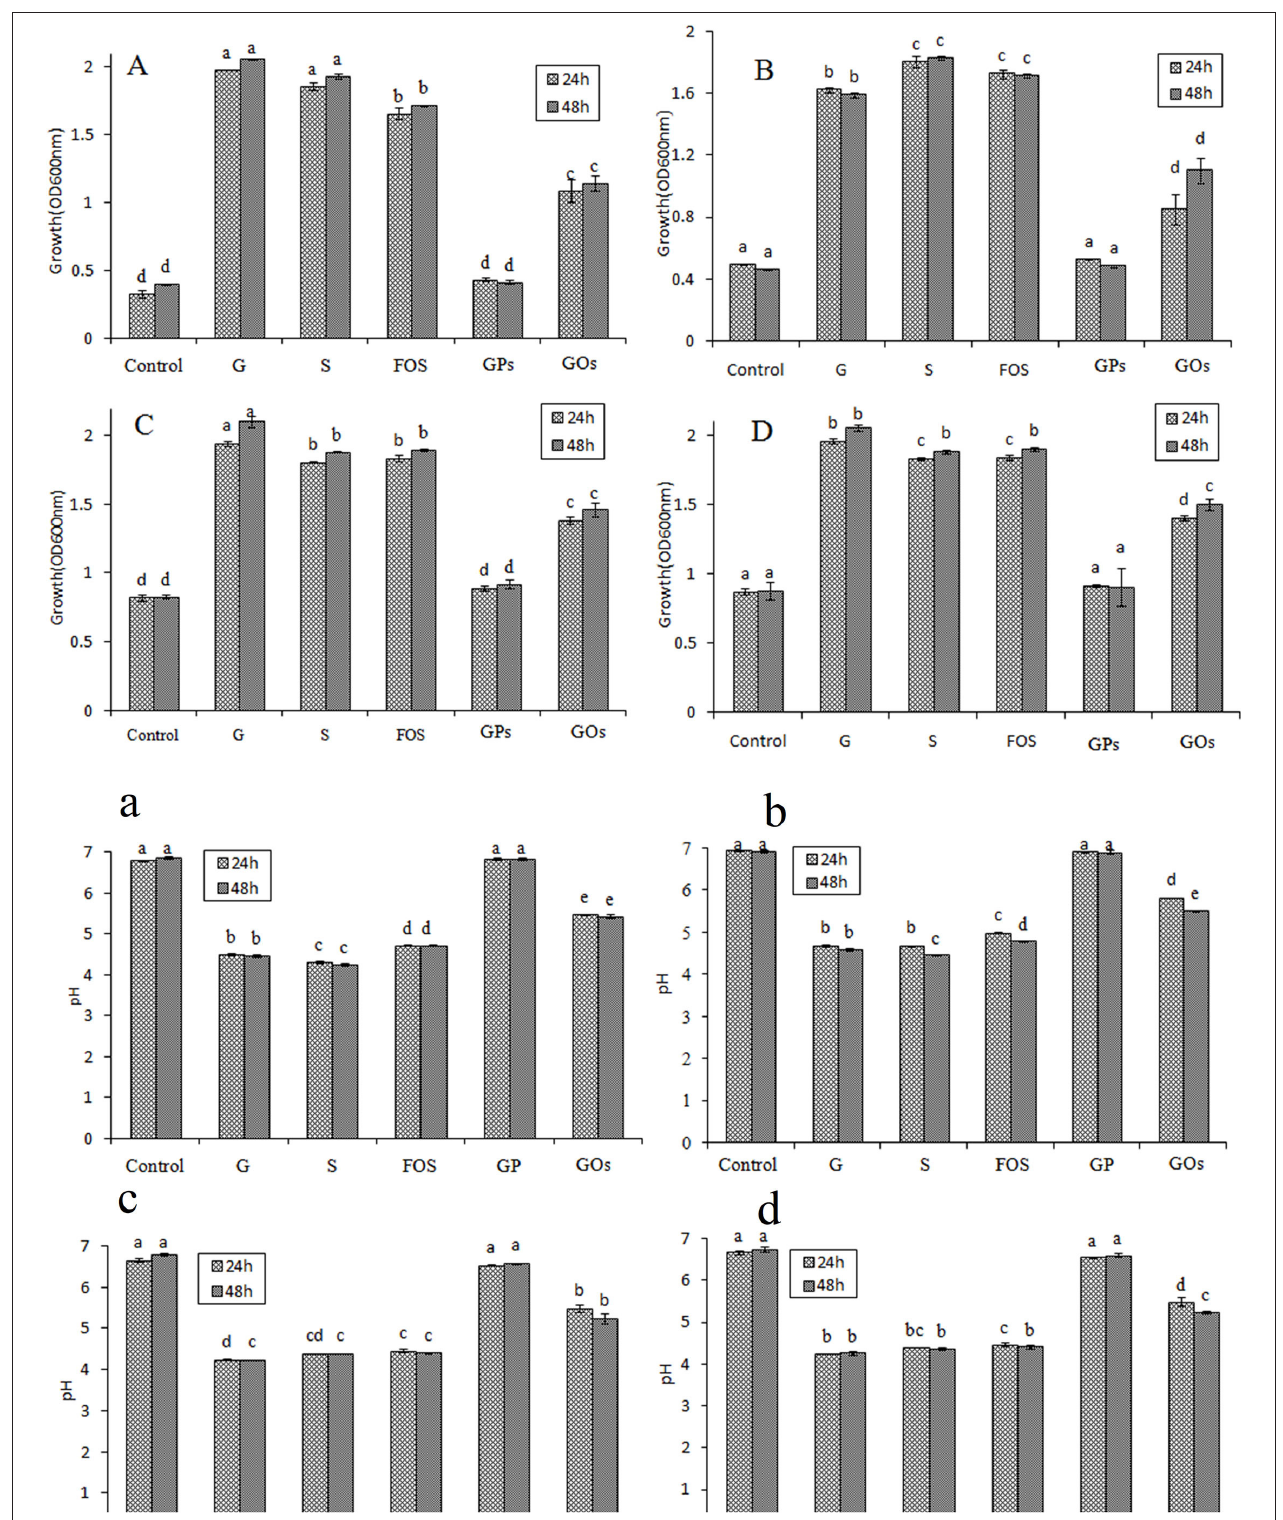
FIGURE 4 | Effects on the growth of Lactobacillus and pH of the medium at 24 and 48h in semisynthetic medium using glucose (G), sucrose (S), FOS, GPs, GOs as the sole carbon source and no carbon medium as control (A/a: L. plantarum ; B/b: L. johnsonii ; C/c: L. paracasei ; D/d: L. casei .).